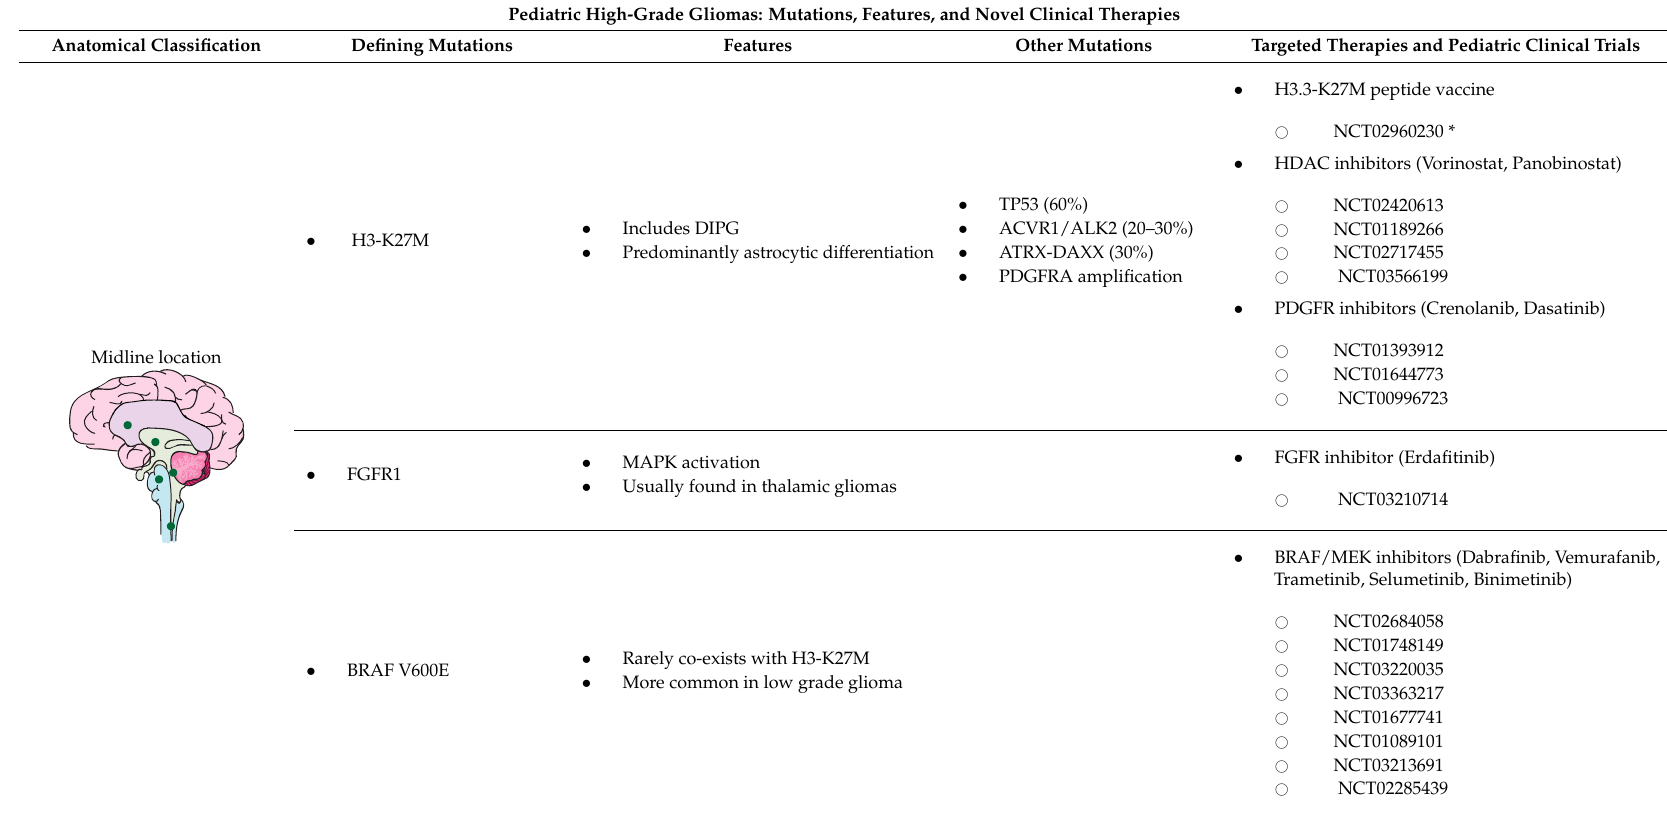
Table 1. Subtypes of pediatric high-grade gliomas, relevant mutations and features, and pediatric clinical trials designed to target these mutations. Diffuse intrinsic